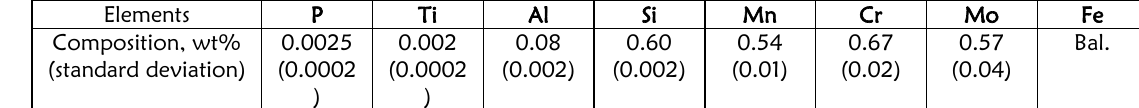
Table 2: Analyzed major elements in the bolt